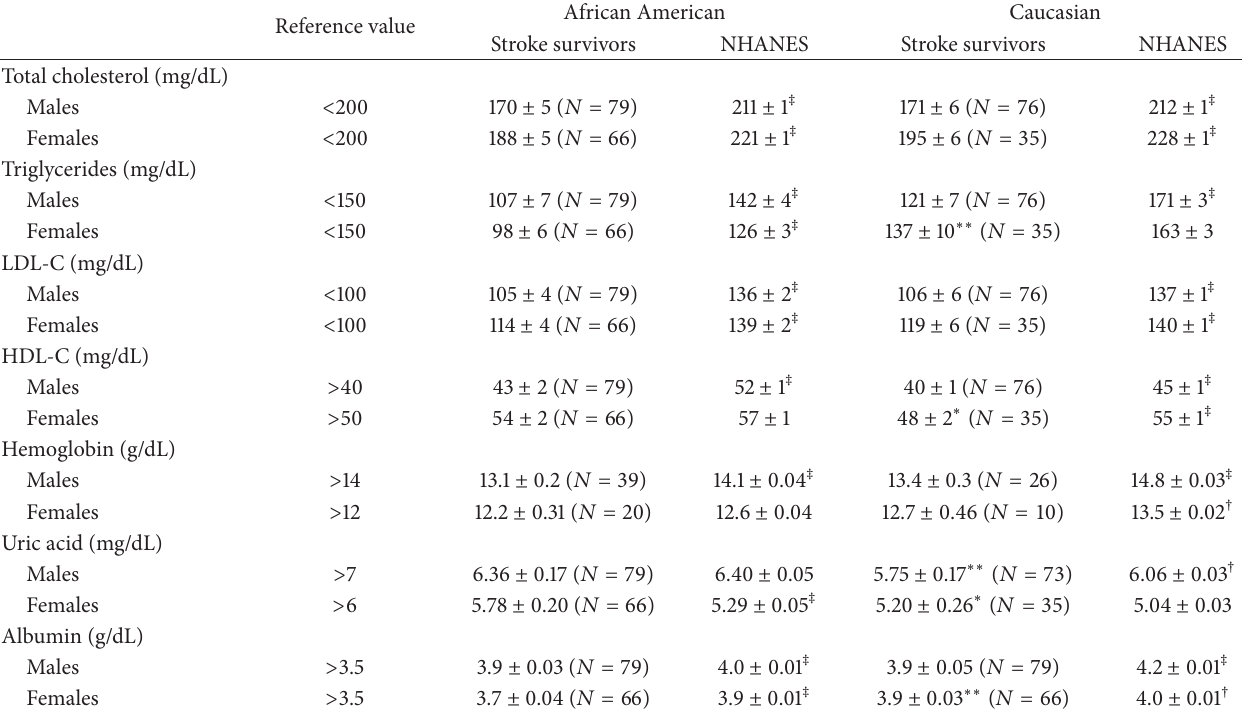
Mean ± SEM. ∗ 𝑃 < 0.05 ; ∗∗ 𝑃 < 0.01 : significantly different from African American stroke survivors. † 𝑃 < 0.05 ; ‡ 𝑃 < 0.01 : significantly different from stroke survivors of the same race.